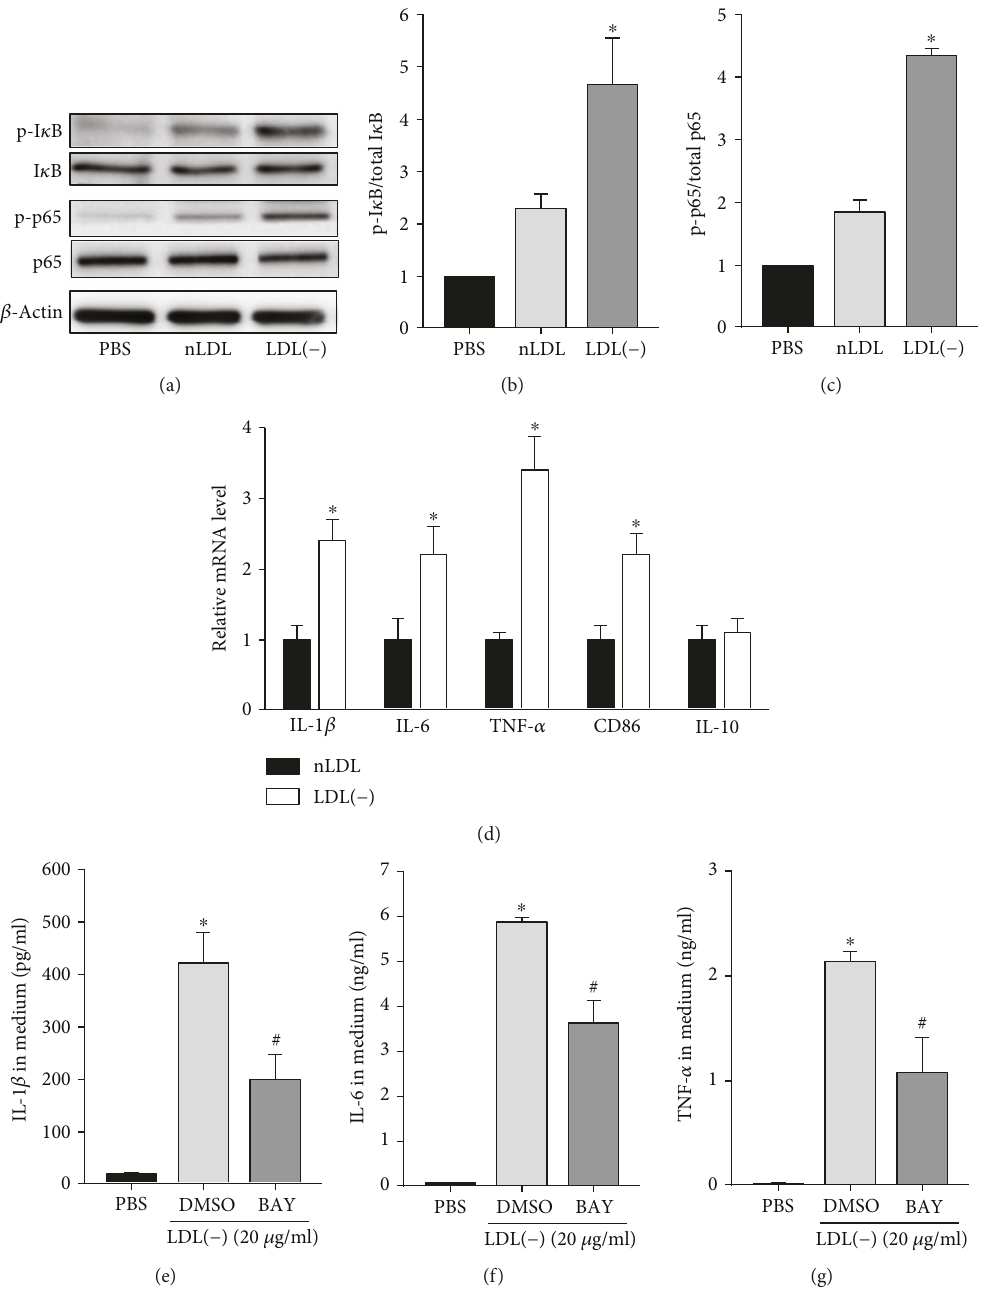
Figure 3: LDL(-)-induced activation of NF- κ B and expressions of NF- κ B downstream genes. (a) THP-1 macrophages were incubated with 20 μ g/ml of native (n)LDL or LDL(-) for 2 h, and then protein levels of total and phosphorylated I κ B (I κ B and p-I κ B, respectively) and p65 (p65 and p-p65, respectively) were determined by Western blotting. β -Actin was used as a loading control. (b, c) Relative levels of p-I κ